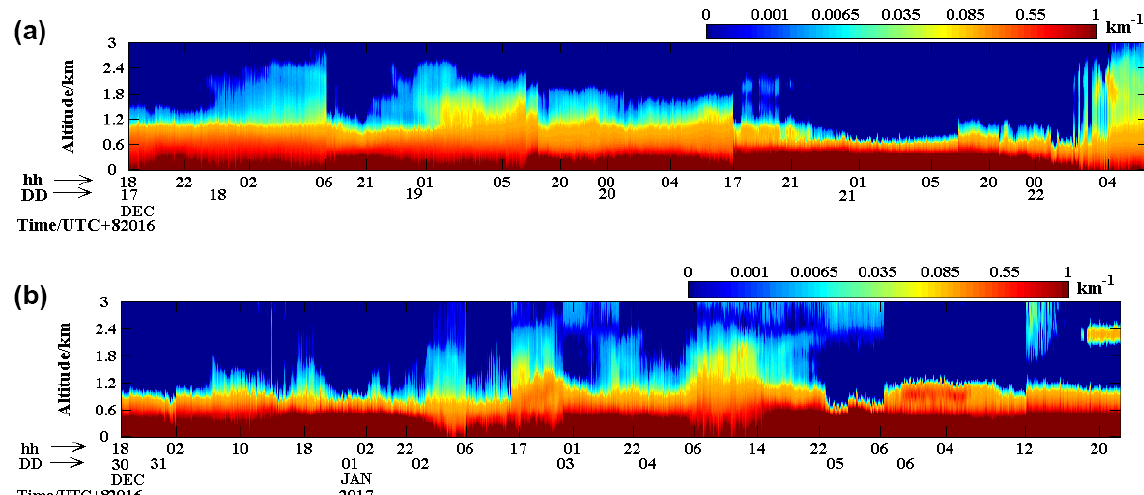
Figure 3. Space–time diagram of AEC in the northwest of downtown Beijing during two haze episodes around 1 January 2017.